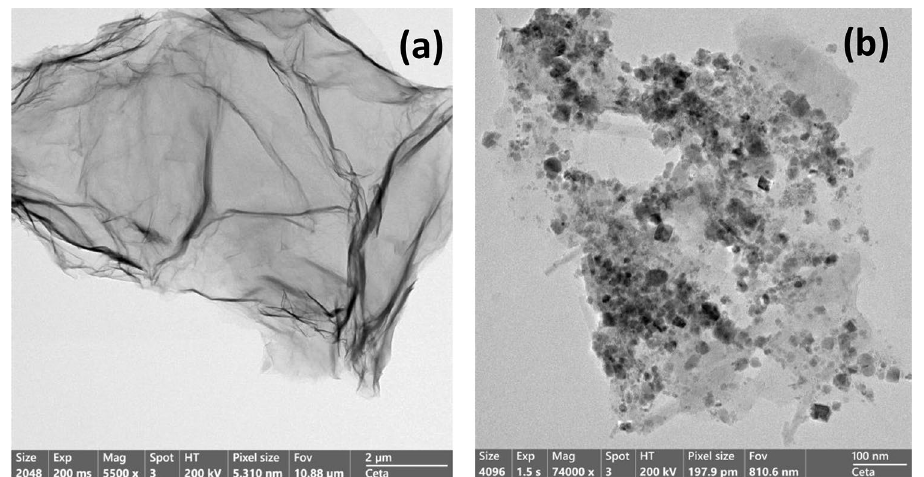
Figure 4. HR-TEM micrographs of ( a ) rGO and (b ) rGO-P